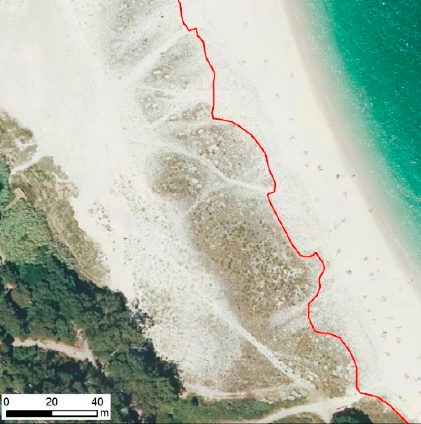
Figure 3. Example of manual shoreline definition on a 2017 orthophotograph.